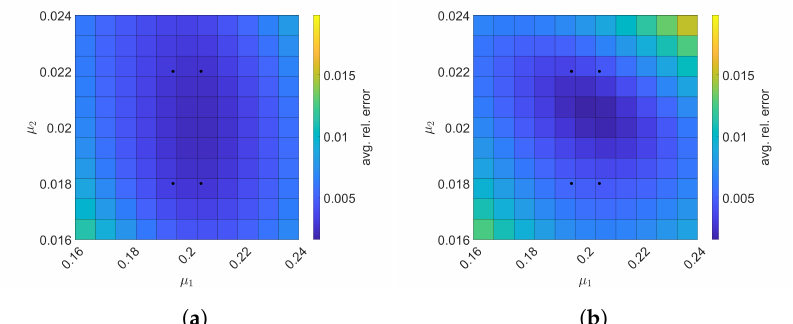
Figure 22. 2D linear convection diffusion equation with source term. The comparison of the Galerkin and LSPG ROMs for predictive cases. The block dots indicate the train parameters. ( a ): Galerkin, ( b ):